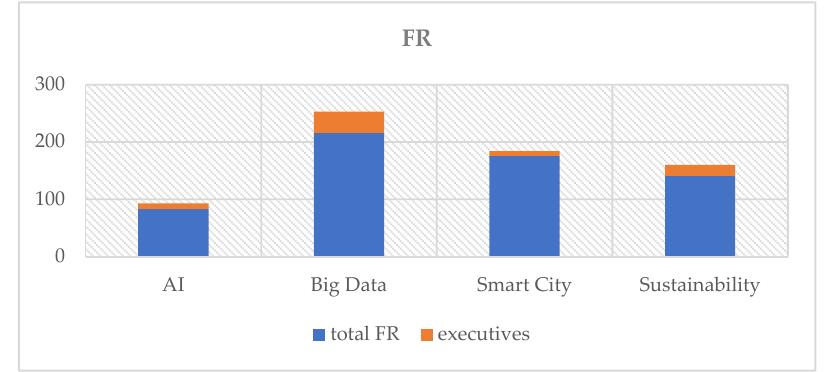
Figure 6. The number of job offers in the energy sector in Canada with selected skills required: the total number and the number of job posts for executives.